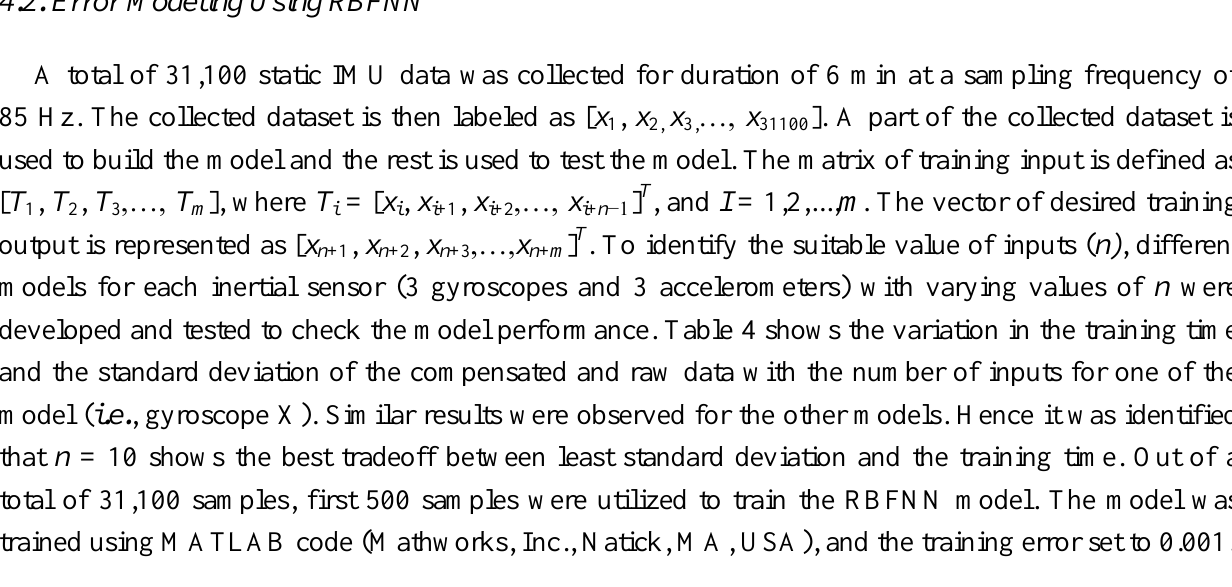
Table 4. Performance of gyroscope X with varying number of